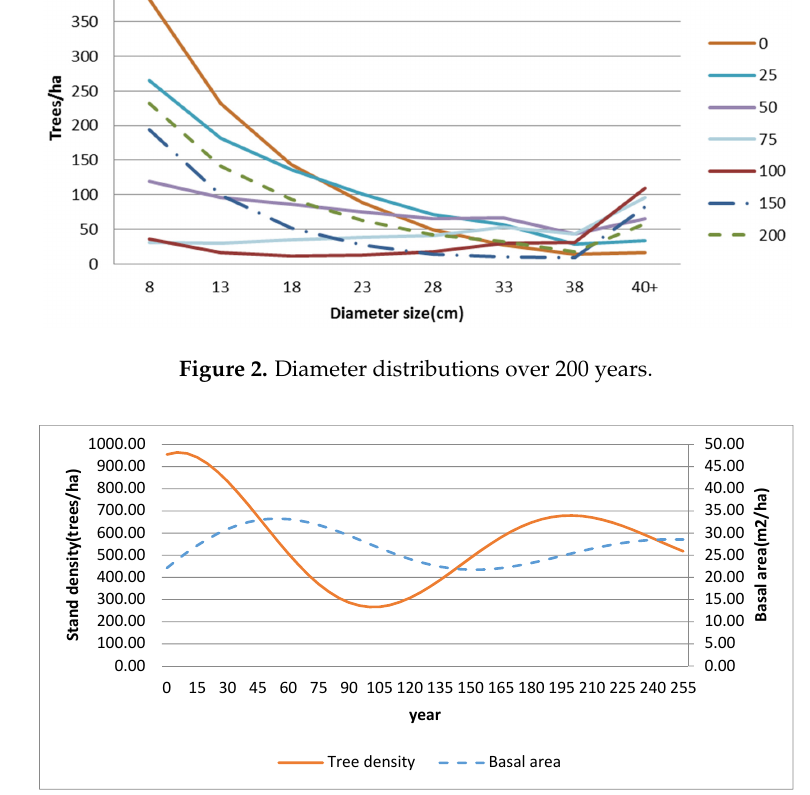
Figure 3. Long ‐ term forest stand dynamics.